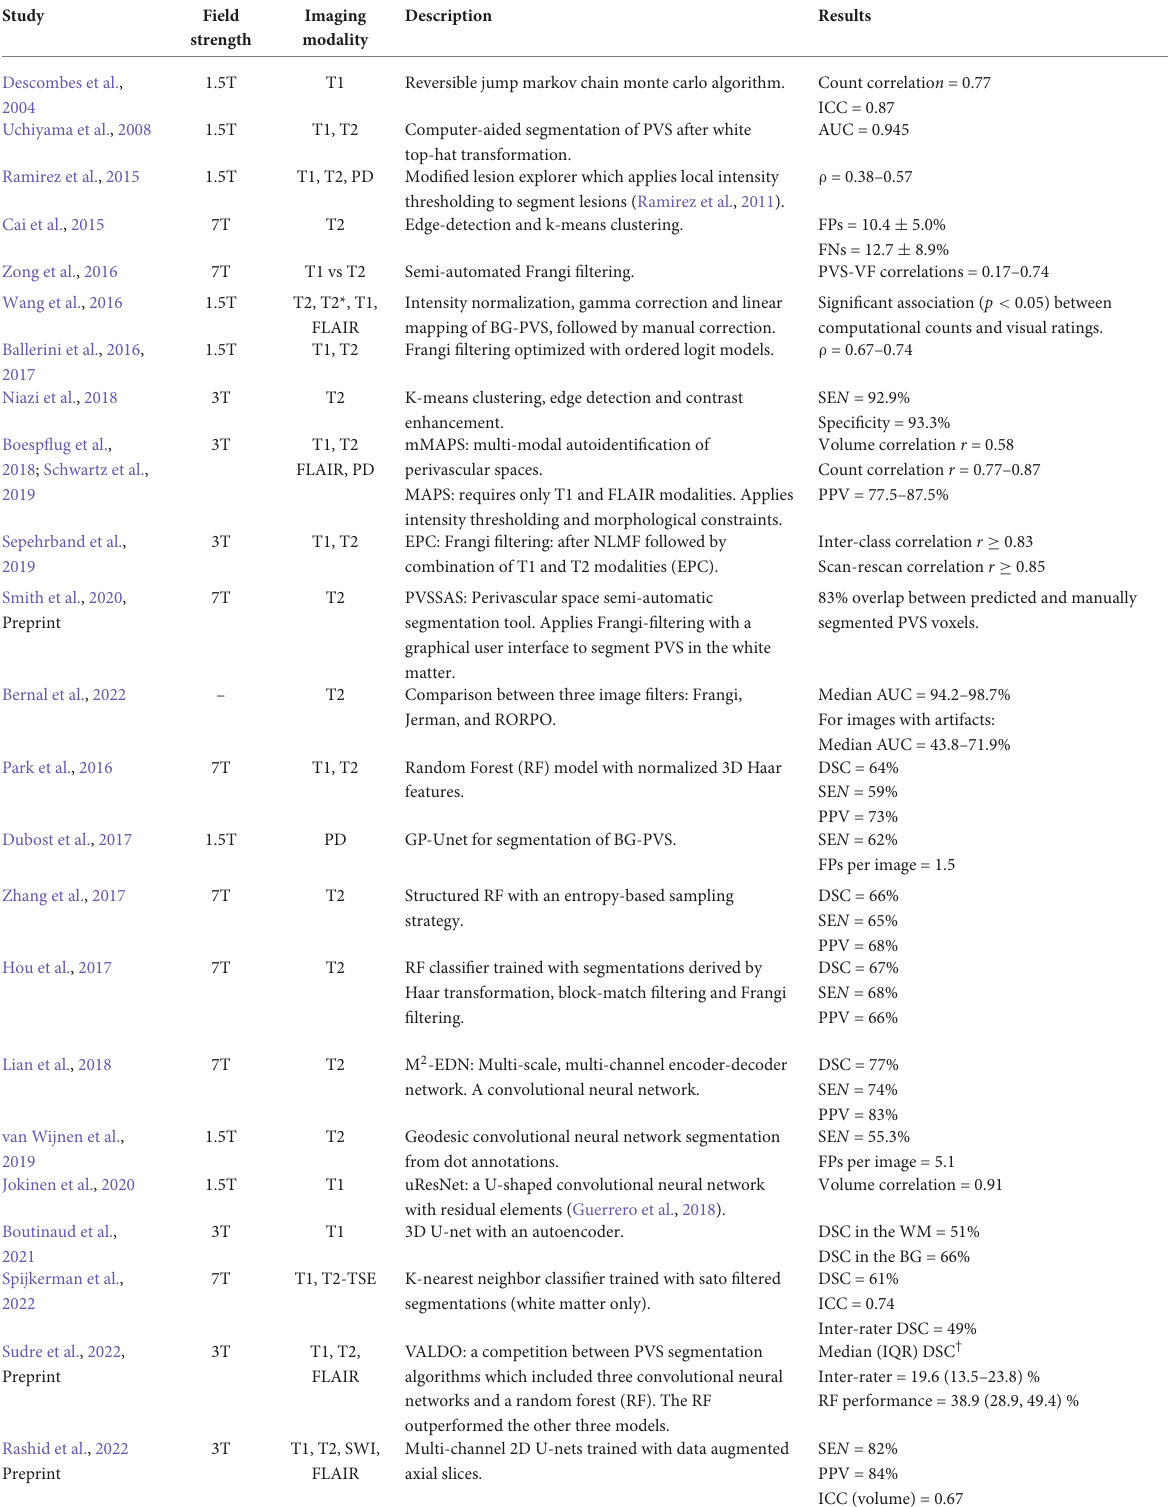
TABLE 1 Summary of PVS segmentation methods and their results.